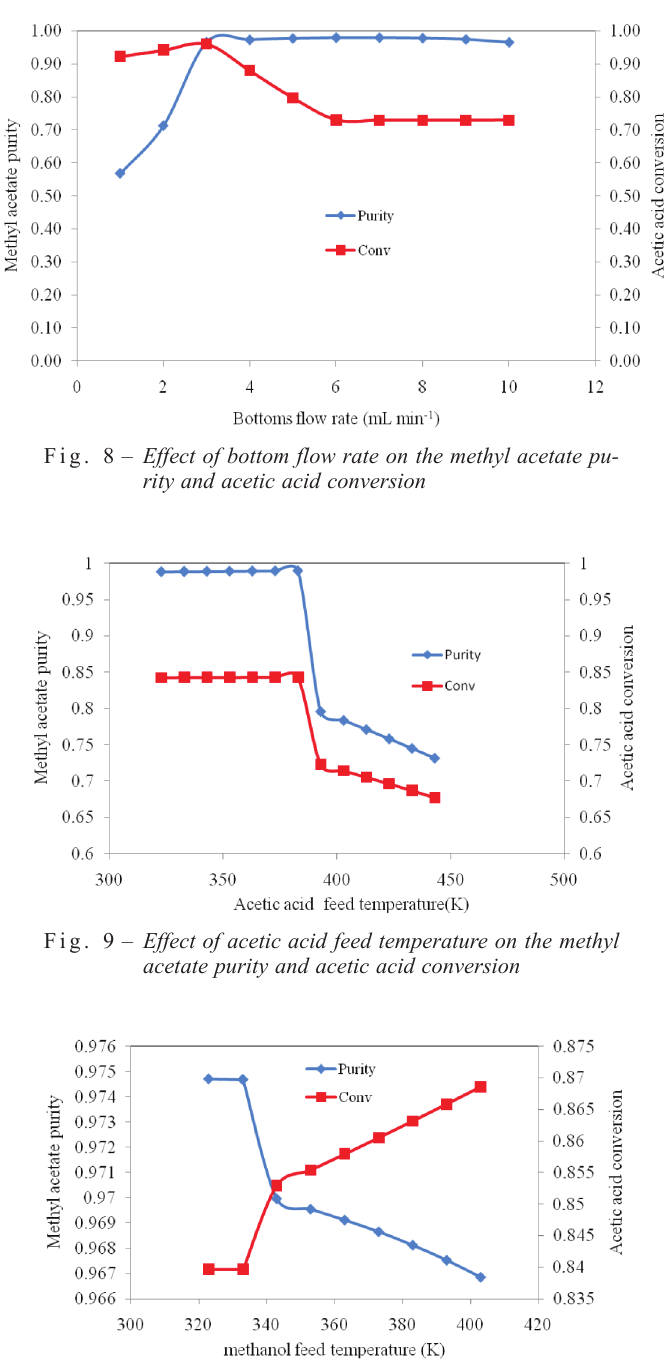
Fig. 10 – Effect of methanol feed temperature on the methyl acetate purity and acetic acid